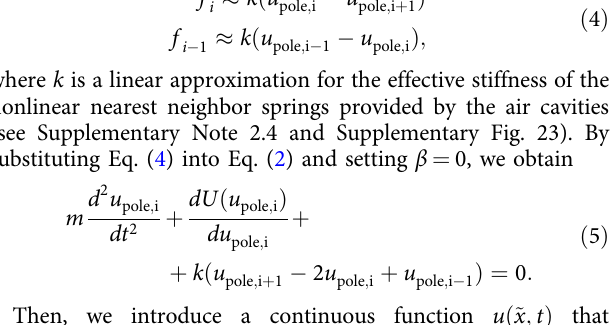
Fig. 4 Analytical and numerical results in the absence of dissipation. a Schematic of our system, showcasing the i − 1, i and i + 1 shells during the propagation of a transition waves that sequentially switches the shells from one stable state to another. b Discrete mass-spring model used to represent the response of our system. c , d Effect of the input energy provided to initiate the pulse on ( c ) the pulse velocity, c , and ( d ) the pulse width, w , for three shell geometries with ( H , T total ) = (12.5, 3) mm (yellow), ( H , T total ) = (15, 4) mm (blue) and ( H , T total ) = (17.5, 5) mm (red) and R = 25.4 mm, as predicted by the discrete (markers) and continuum models (lines). e Wave velocity, c , and ( f ) width, w , vs. input energy, E in , for an array of universally bistable shells with ( H , T total ) = (15, 4) mm and R = 25.4 mm, for three values of shell-to-shell spacing, L t = 32 mm (yellow), 28 mm (blue) and 22 mm (red), as predicted by the discrete (markers) and continuum model (lines). Note that in c – f we report two analytical solutions: one in which c is obtained by solving Eq. (13) (solid lines) and one in which c is given by Eq. (14) (dashed